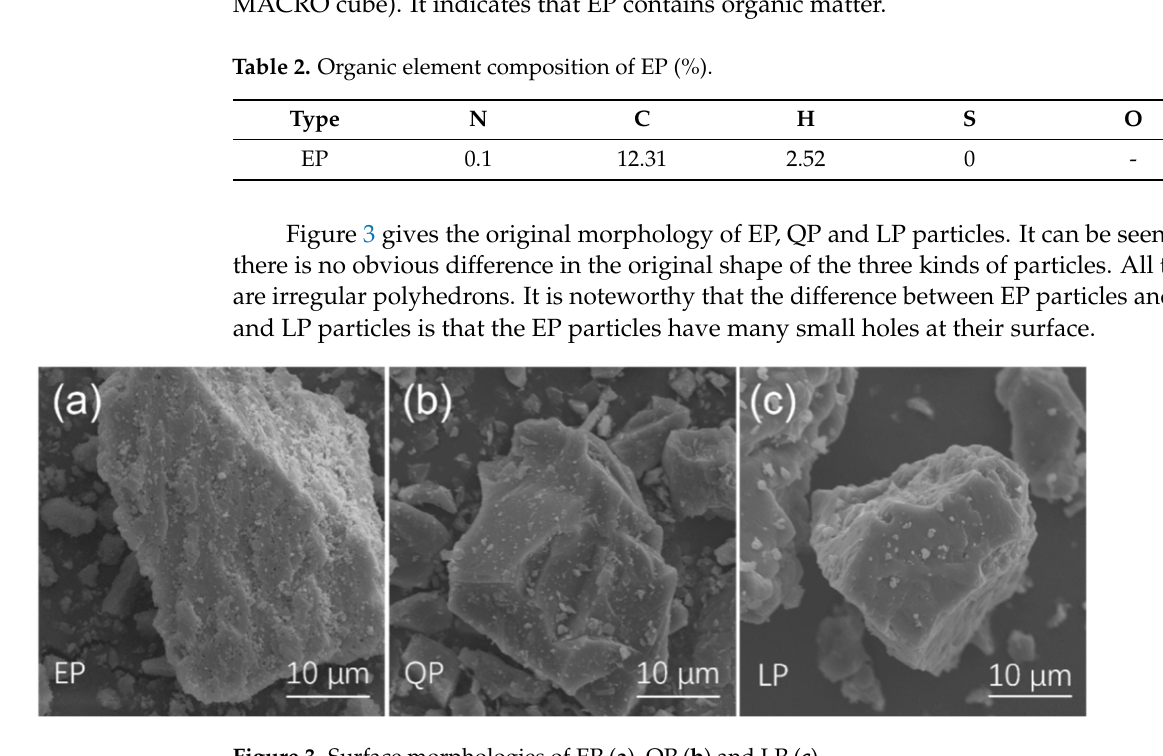
Figure 3. Surface morphologies of EP (a), QP (b) and LP (c).